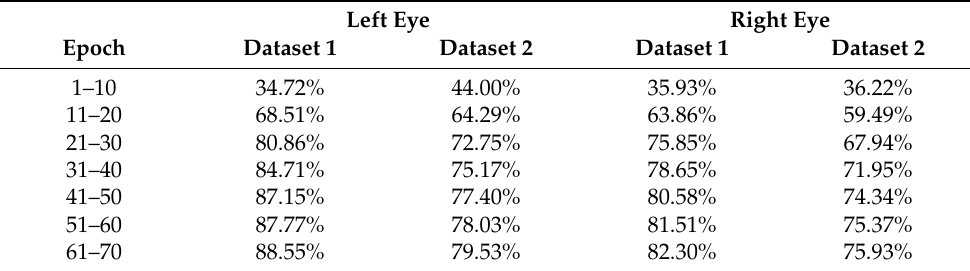
Table 5. Results for ARCH-L and ARCH-R architectures—averaged accuracy for the range of training